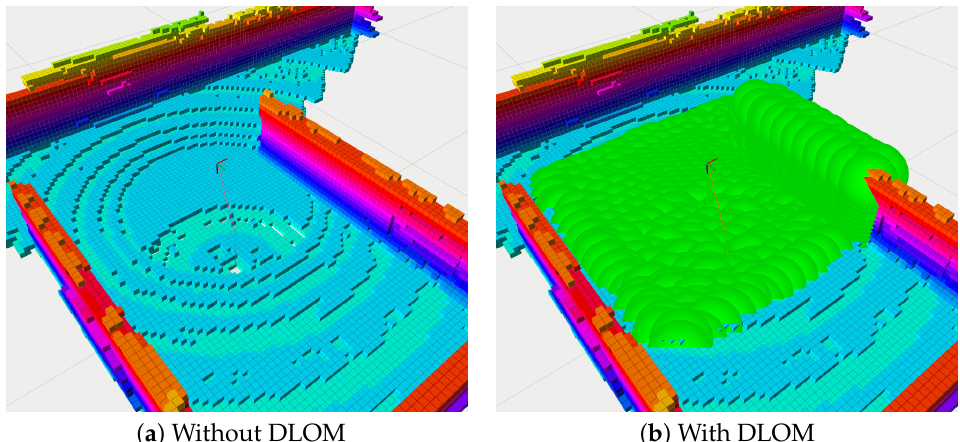
Figure 4. Dynamic Local Obstacle Mapping (DLOM).